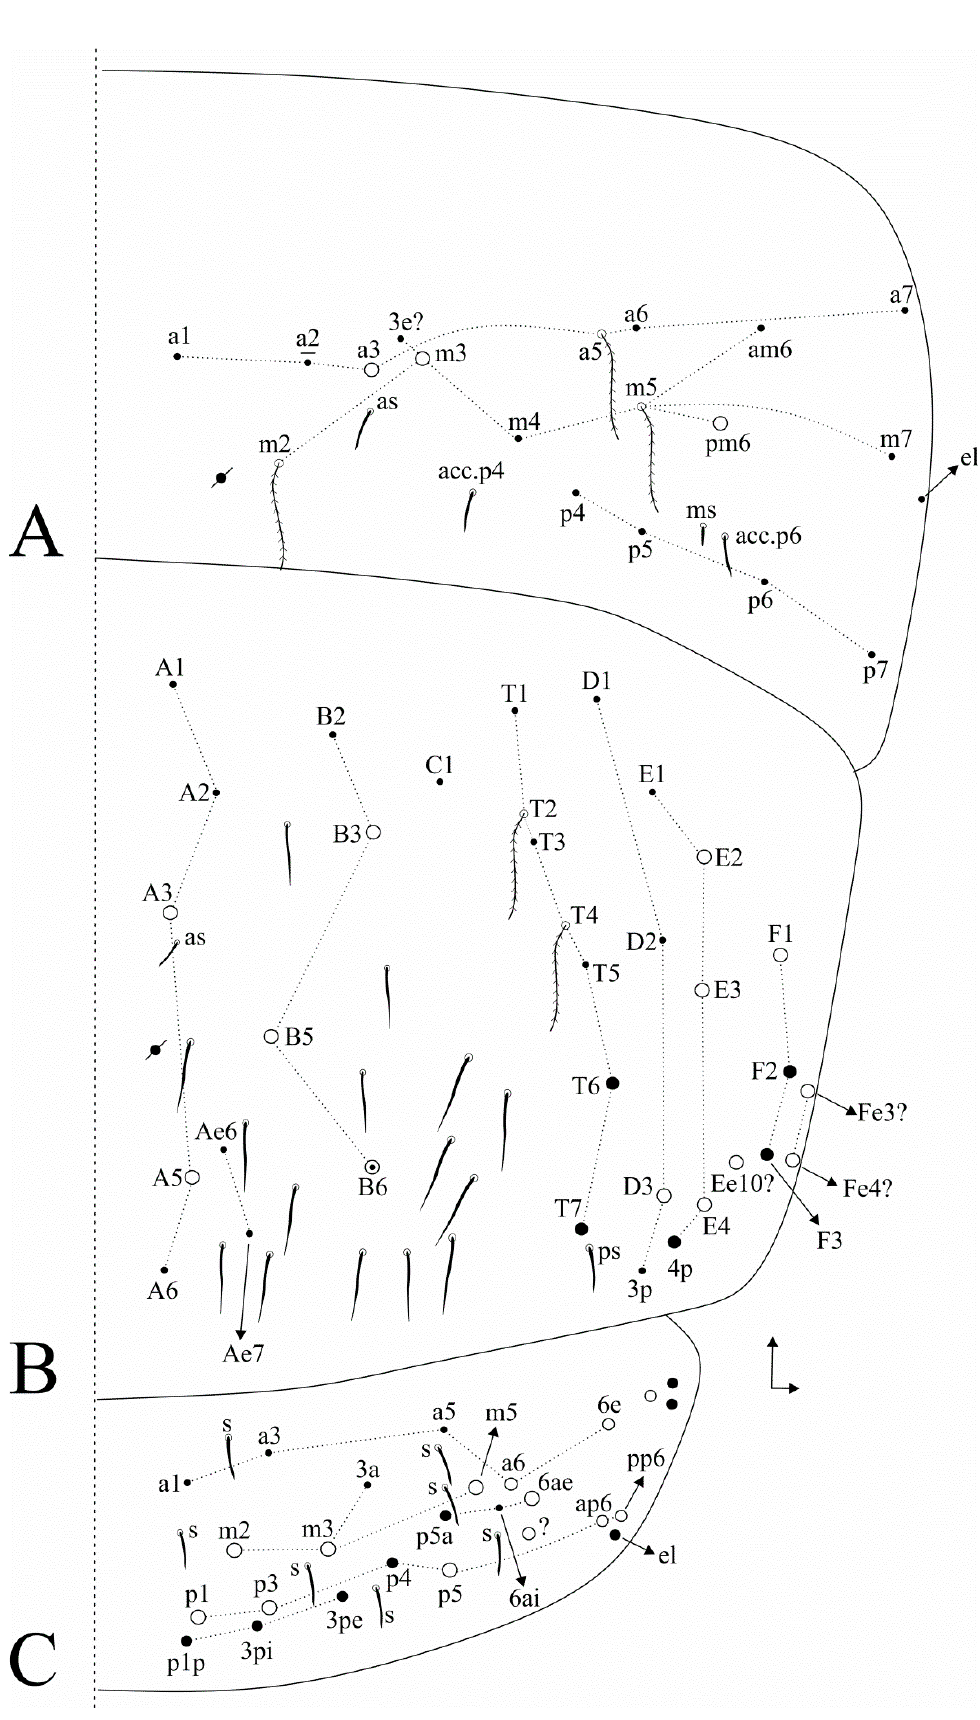
Figure 5. Dicranocentrus abestado sp. nov. trunk dorsal chaetotaxy (right side): ( A ) Abd. III; ( B ) Abd. IV; ( C ) Abd. V.